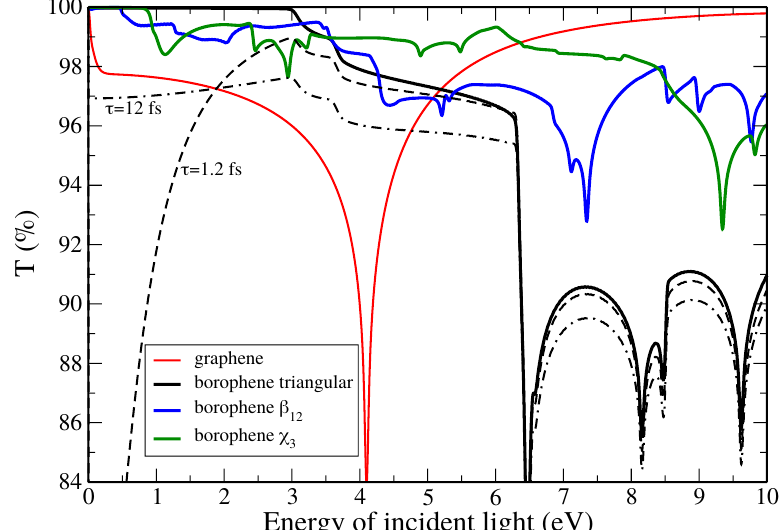
Figure 5. Optical transmittance T of graphene and borophene monolayers (electric field in oblique direction) without Drude corrections (thick lines). To illustrate the effect of Drude corrections, two representative values of scattering time τ = 1.2 and 12fs (dashed and dotted-dahsed black lines) are also displayed for the case of buckled triangular